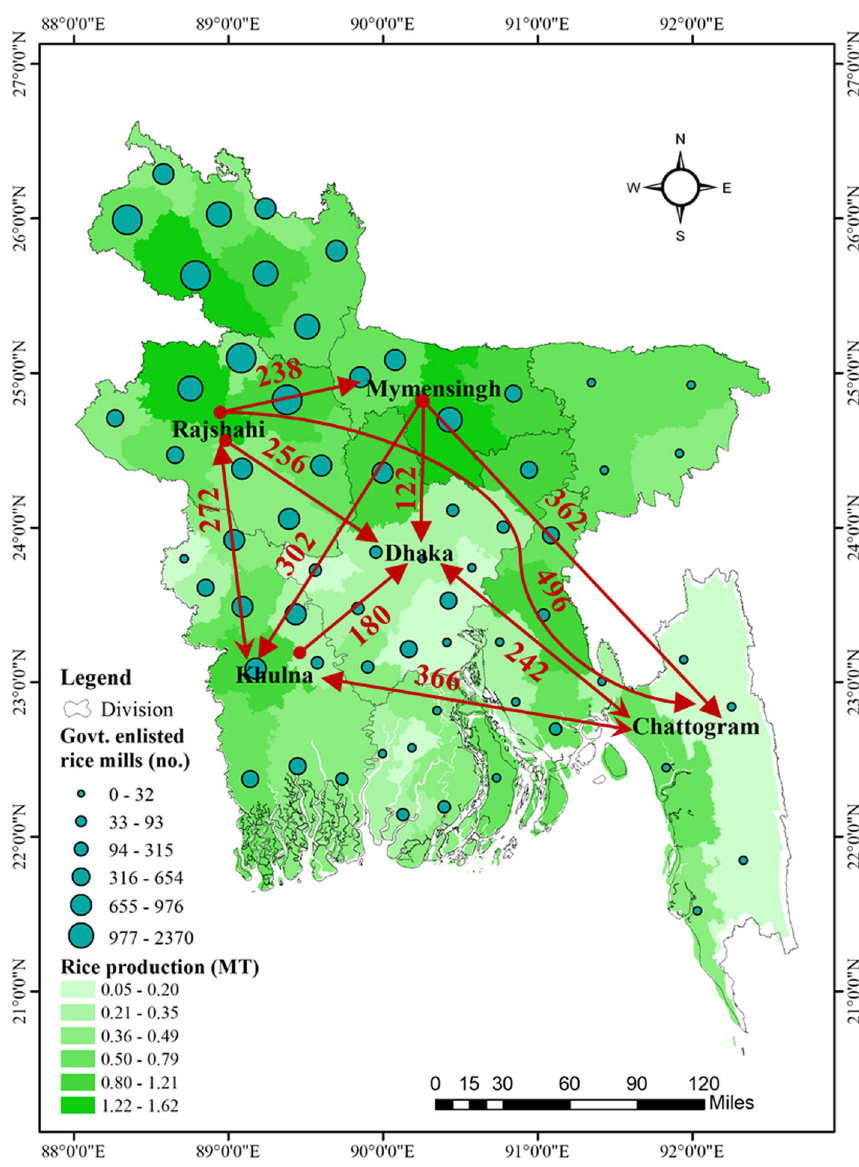
Fig. 3 Direction of price causality among major rice market pairs of Bangladesh. Note: Single and double arrows represent the unidirectional and bidirectional causality, respectively. For example, ‘Mymensingh D h aka ’ represents the price of Dhaka market is determined by the price of Mymensingh. → Conversely, ‘Khulna Chattogram’ represents the price of Khulna market is determined by the price of ↔ Chattogram market and vice versa. The numerical value of the graph shows the market distances in